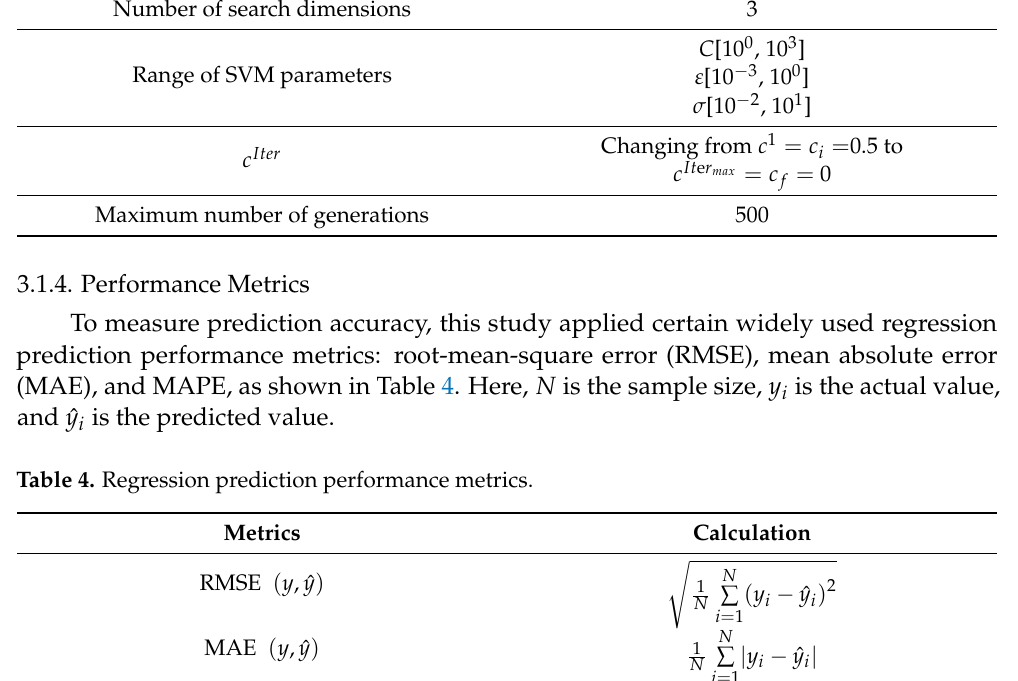
Figure 6. Flow chart of the prediction models.